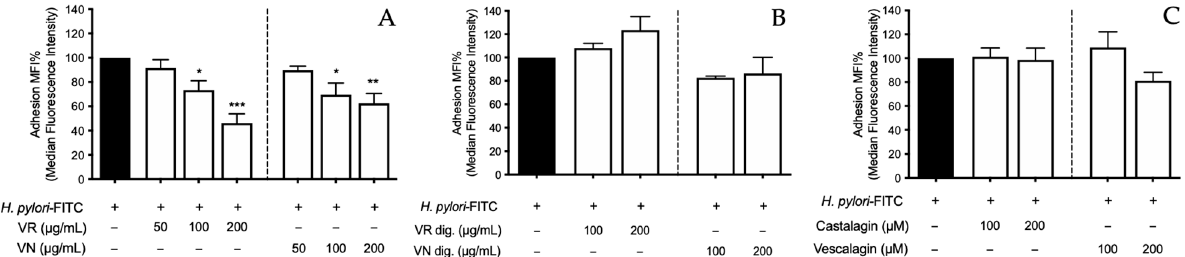
Figure 8. Preventive effect of Castanea sativa Mill. leaf extracts and ellagitannins on H. pylori adhesion. GES-1 cells were treated for 1 h with leaf extracts before ( A ) and after ( B ), or ellagitannins ( C ) in vitro simulated digestion, prior to H. pylori -FITC infection (ratio 50:1, bacteria/cell). The bacterial adhesion to GES-1 cells was measured as fluorescence intensity by cytofluorimeter. Results are expressed as the mean ± SEM ( n = 3) of the relative percentage in comparison to H. pylori growth (black bar), to which the value of 100% was arbitrarily assigned. * p < 0.05, ** p < 0.01, and *** p < 0.001 vs. H. pylori . MFI%, median fluorescence intensity; FITC, fluorescein isothiocyanate; VR, Castanea sativa Mill. var. verdesa leaves extract; VN, Castanea sativa Mill. var. venegon leaves extract; dig., in vitro simulated digestion.